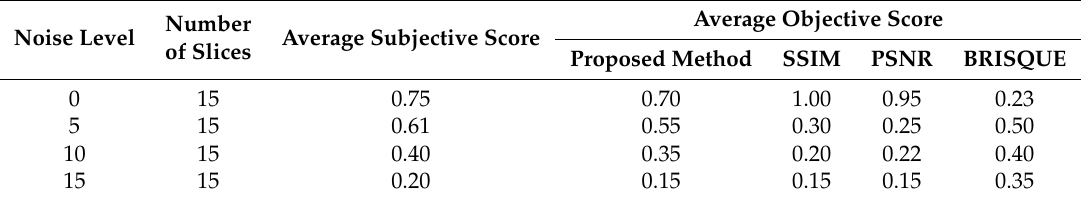
Table 3. Comparative Performance Evaluation of the Proposed Method with SSIM, PSNR and BRISQUE Quality Metrics using Breast MRI Images.